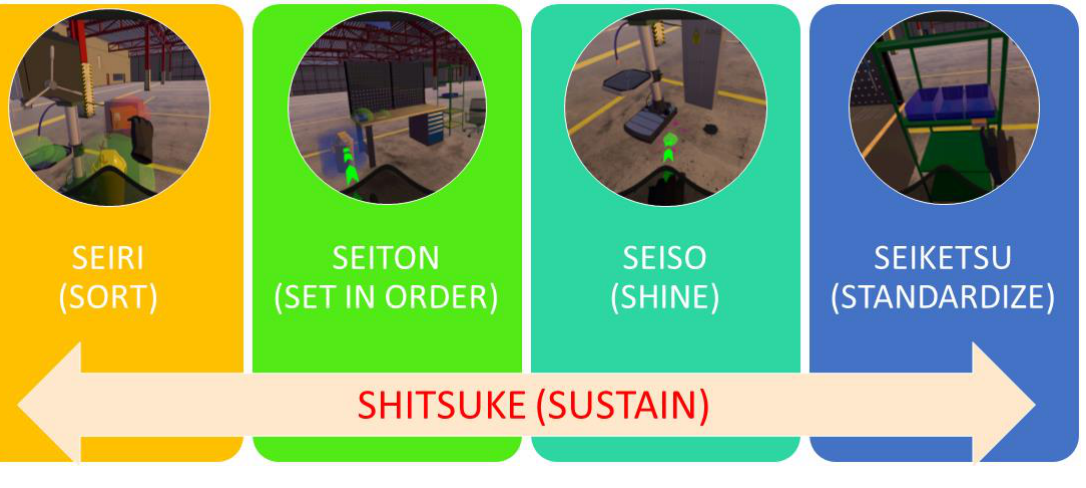
Figure 1. The 5S method.